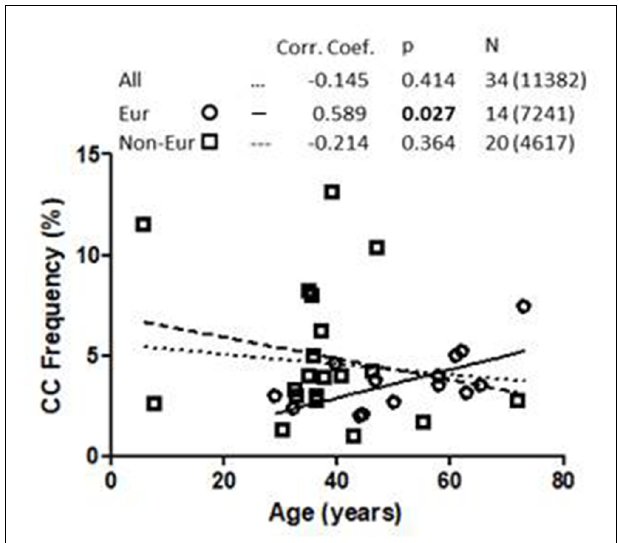
FIGURE 1 | Association of 1513CC P2X7 genotype frequency with the age in All, European and Non-European cohorts. Legend. Corr. Coef., Pearson correlation coefficient. N: cohort number (total number of subjects).